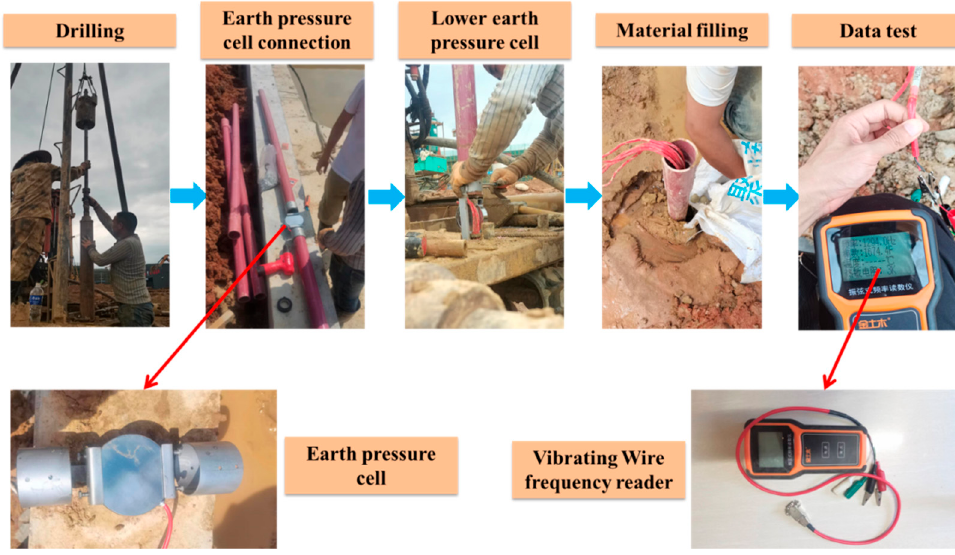
Figure 4. Main steps of earth pressure test.